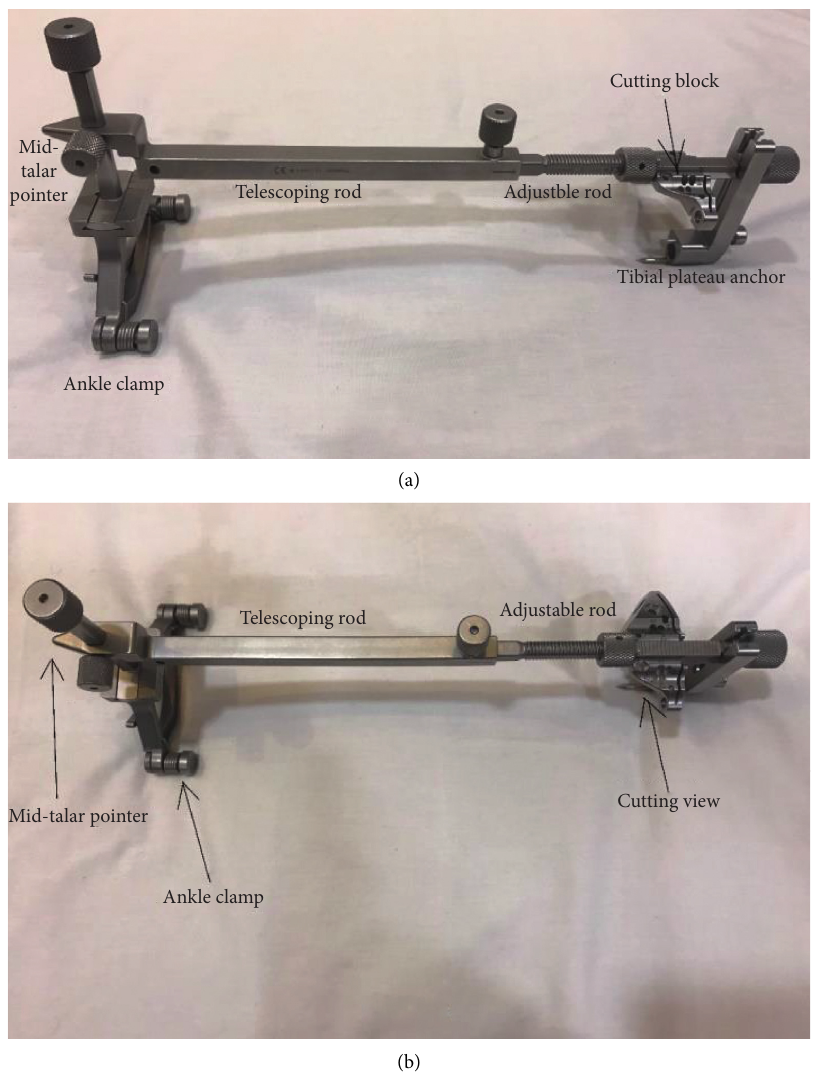
Figure 2: The extramedullary cutting guide. (a) Side view. (b) Top view.